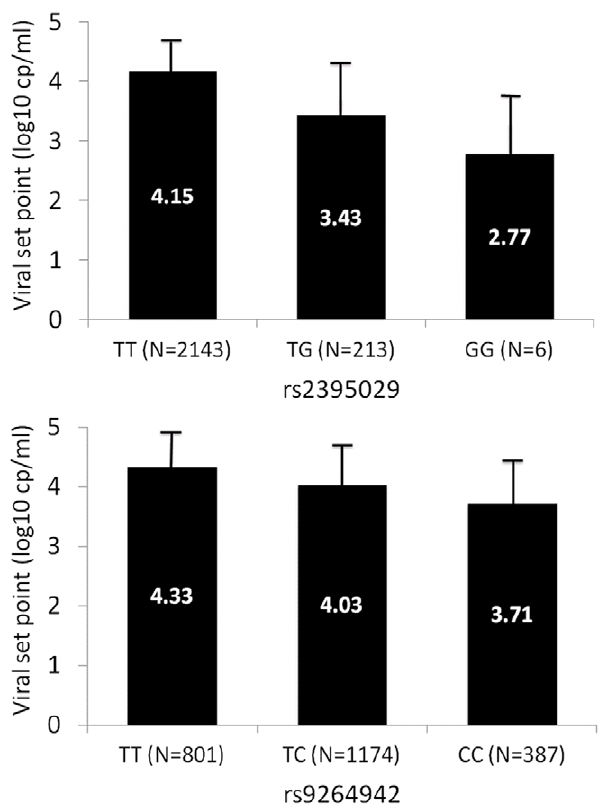
Figure 2. Correlation between HIV-1 set point and the genotypes of the top associated SNPs. HIV-1 viremia at set point strongly associates with rs2395029 (upper panel) and rs9264942 (lower panel) genotypes. The rs2395029 minor allele G has a frequency of 4.8% and each copy of this allele associates with a 0.7 log lower set point. The rs9264942 minor allele C has a frequency of 41.2%, and each copy of this allele associates with a 0.3 log lower set point. Mean and Standard Deviation (error bars) are represented for the respective